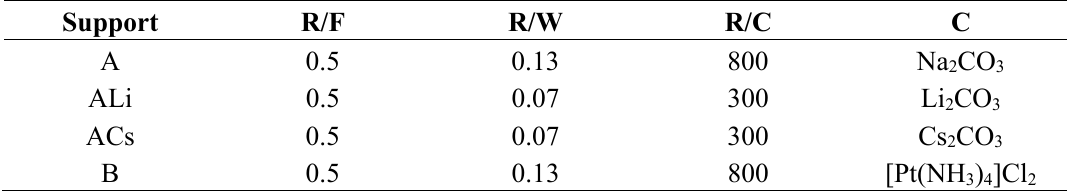
Table 7. Recipes used in the preparation of organic